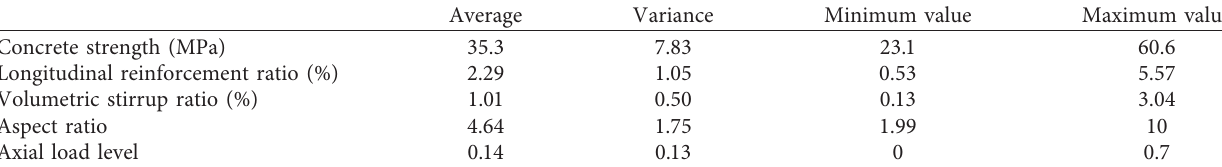
Table 2: Statistical parameters of experimental components.